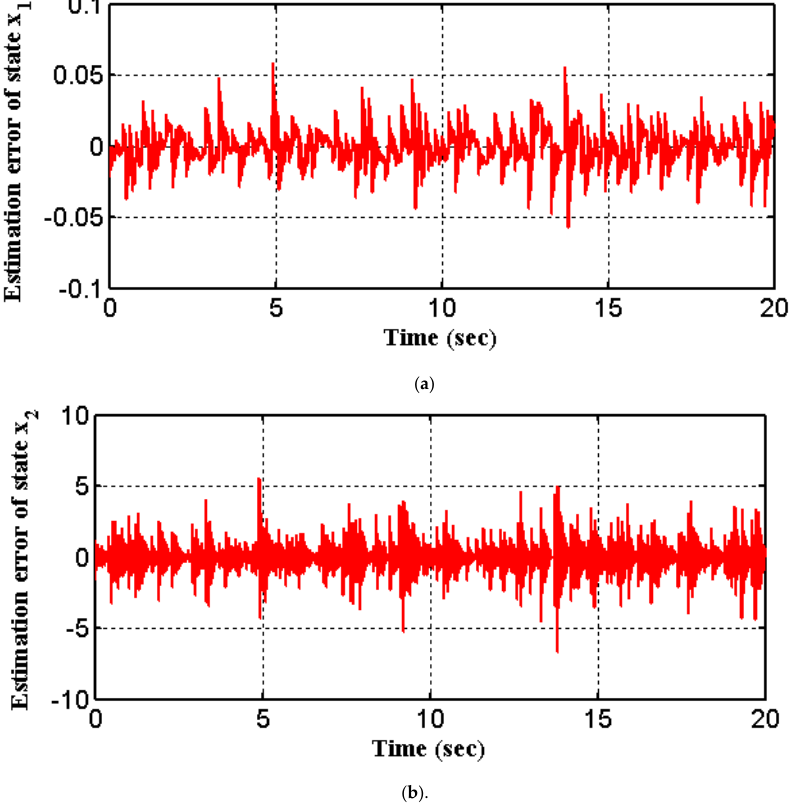
Figure 12. Estimation error with measurement noise using N-ADRC, ( a ) e 1 ( b ) e 2 .